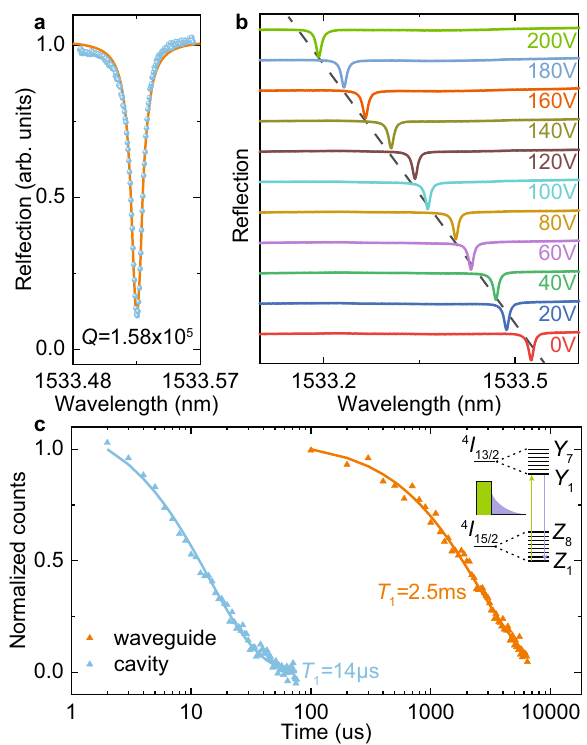
Fig. 2 | Device characterization. a Re fl ection spectrum of the resonator. A Lor- entzian fi t (orange curve) yields Q =1.58×10 5 . b Resonance frequency shift under different applied voltage. The re fl ection spectrum of each voltage is offset for clarity. A tuning rate of 1.6 pm/V is extracted. c Time-domain fl uorescence mea- surement of Er ions in the waveguide (orange) and cavity (blue) and exponential fi tting.Enhancementofemissionrateisshownbytheshortenedlifetime( T thecavity.TheinsetshowsanenergyleveldiagramofErions.Wepump(green)on the Y 1 − Z 1 transition centering around 1532 nm and collect the resonant fl uores- cence